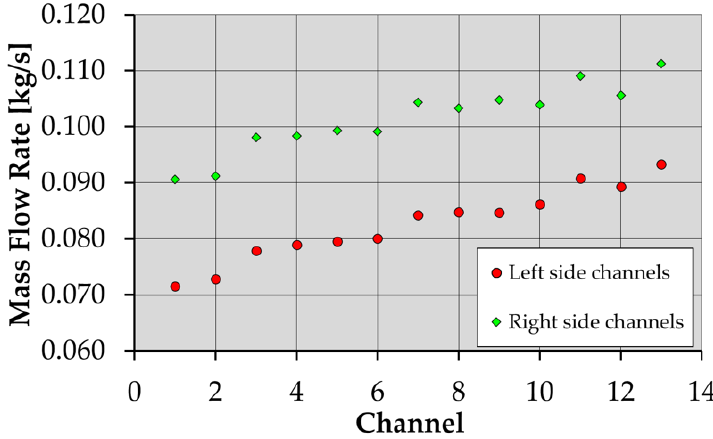
Figure 13. Coolant MFR distribution in the BZ DWTs (recirculation to outlet